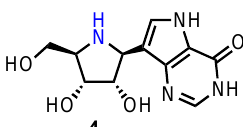
Figure 3. Structure of forodesine 4 .